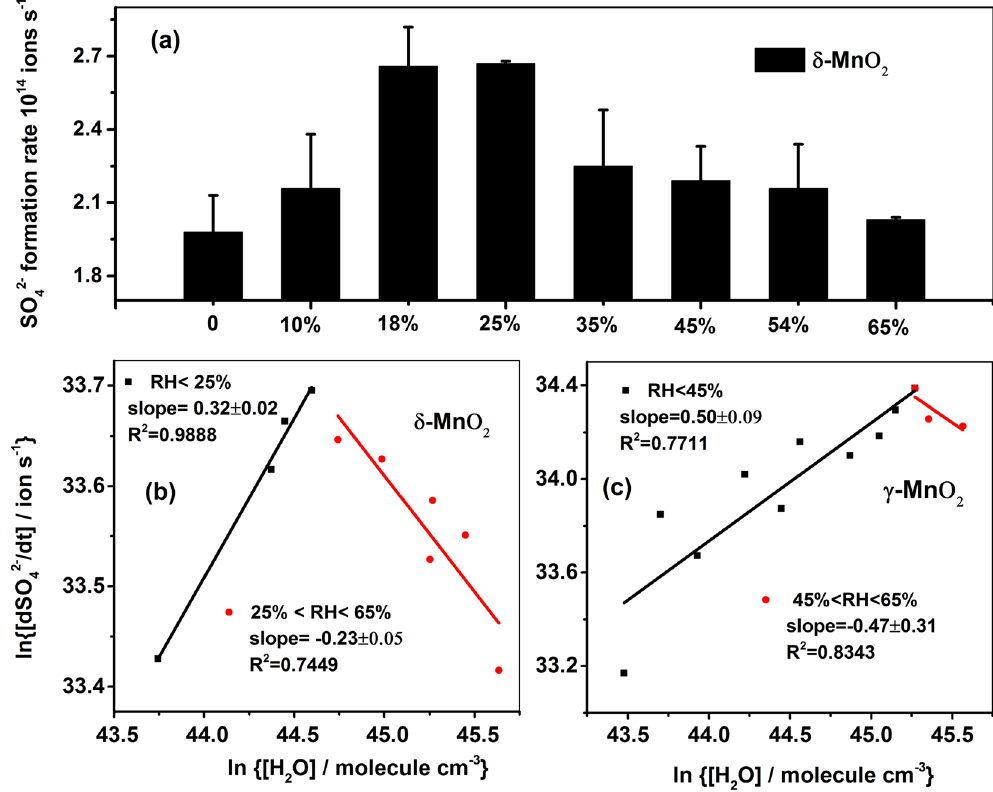
Figure 10. ( a ) Sulfate formation rate on δ -MnO 2 at different RHs, and bilogarithmic plots of the sulfate formation rate versus [H 2 O] on ( b ) δ -MnO 2 and ( c ) γ -MnO 2